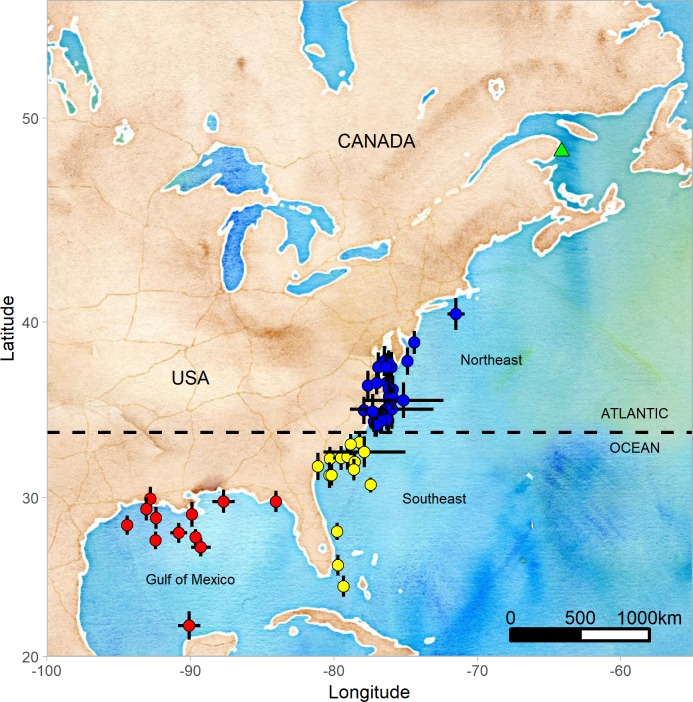
Centroid of wintering location (Dec. 15th–Feb. 15th, mean ± 95% CI) of 58 Northern Gannets nesting on Bonaventure Island, Canada, equipped with a Global Location Sensor (GLS) logger and tracked in 2010–2011 or in 2011–2012.Red dots presented individuals wintering in the Gulf of Mexico, yellow dots in southeast coast of the USA and blue dots in northeast coast of the USA. The map was generated in R (R Core Team, 2016) using the ‘ggmap’ [48] and ‘ggplot2’ packages [49] with map tiles by Stamen Design (www.stamen.com) and data by OpenStreetMap, under ODbL, under CC BY 3.0 (creativecommons.org/licenses/by/3.0/).